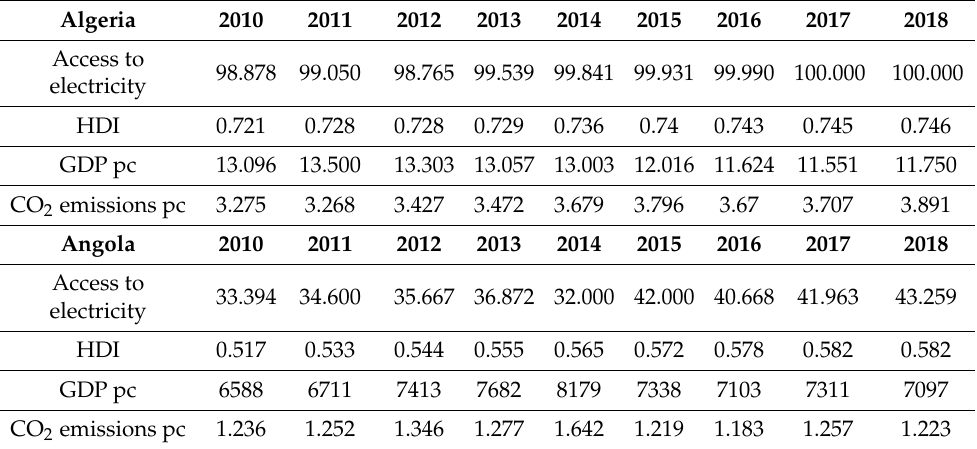
Table 1. The set of time series for two selected African countries, for which the relative degree of grey incidence indices is determined. Source: own study based on data from: